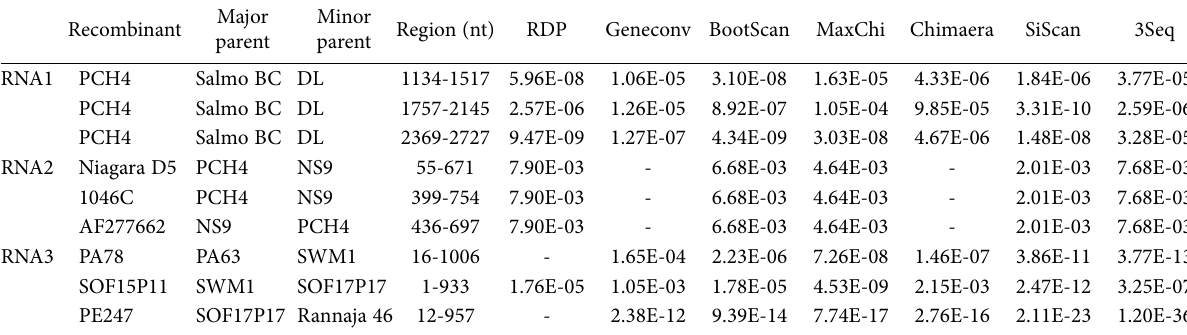
Table 1. Recombination events in genomic RNA1, RNA2 and RNA3 of prune dwarf virus (PDV) predicted by RDP3. Recombinant